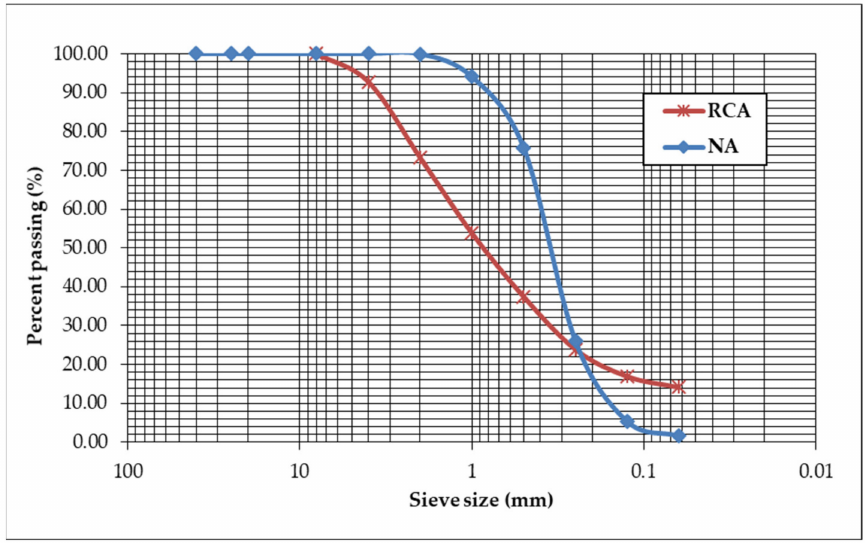
Figure 1. Particle size distribution of NA and